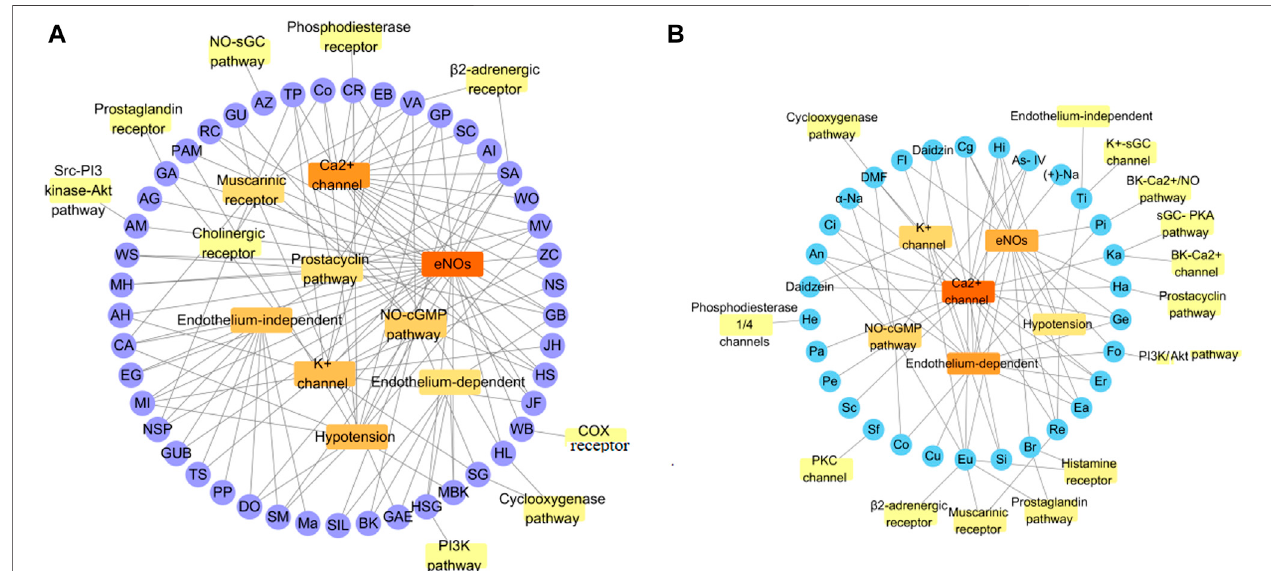
FIGURE3| SomemechanismsofvasodilationcausedbyTMPsandnaturalproducts. (A) VasodilationmechanismofTMPs; (B) VasodilationmechanismofNatural Products. The vasodilatory function of TMPs was mainly concerned with the activation of eNOs, while the natural products were primarily associated with blockage of calcium channel. They also act on other pathways, including sGC-cGMP, potassium channels, muscarinic receptors, cyclooxygenase pathways, prostaglandin I2, etc.